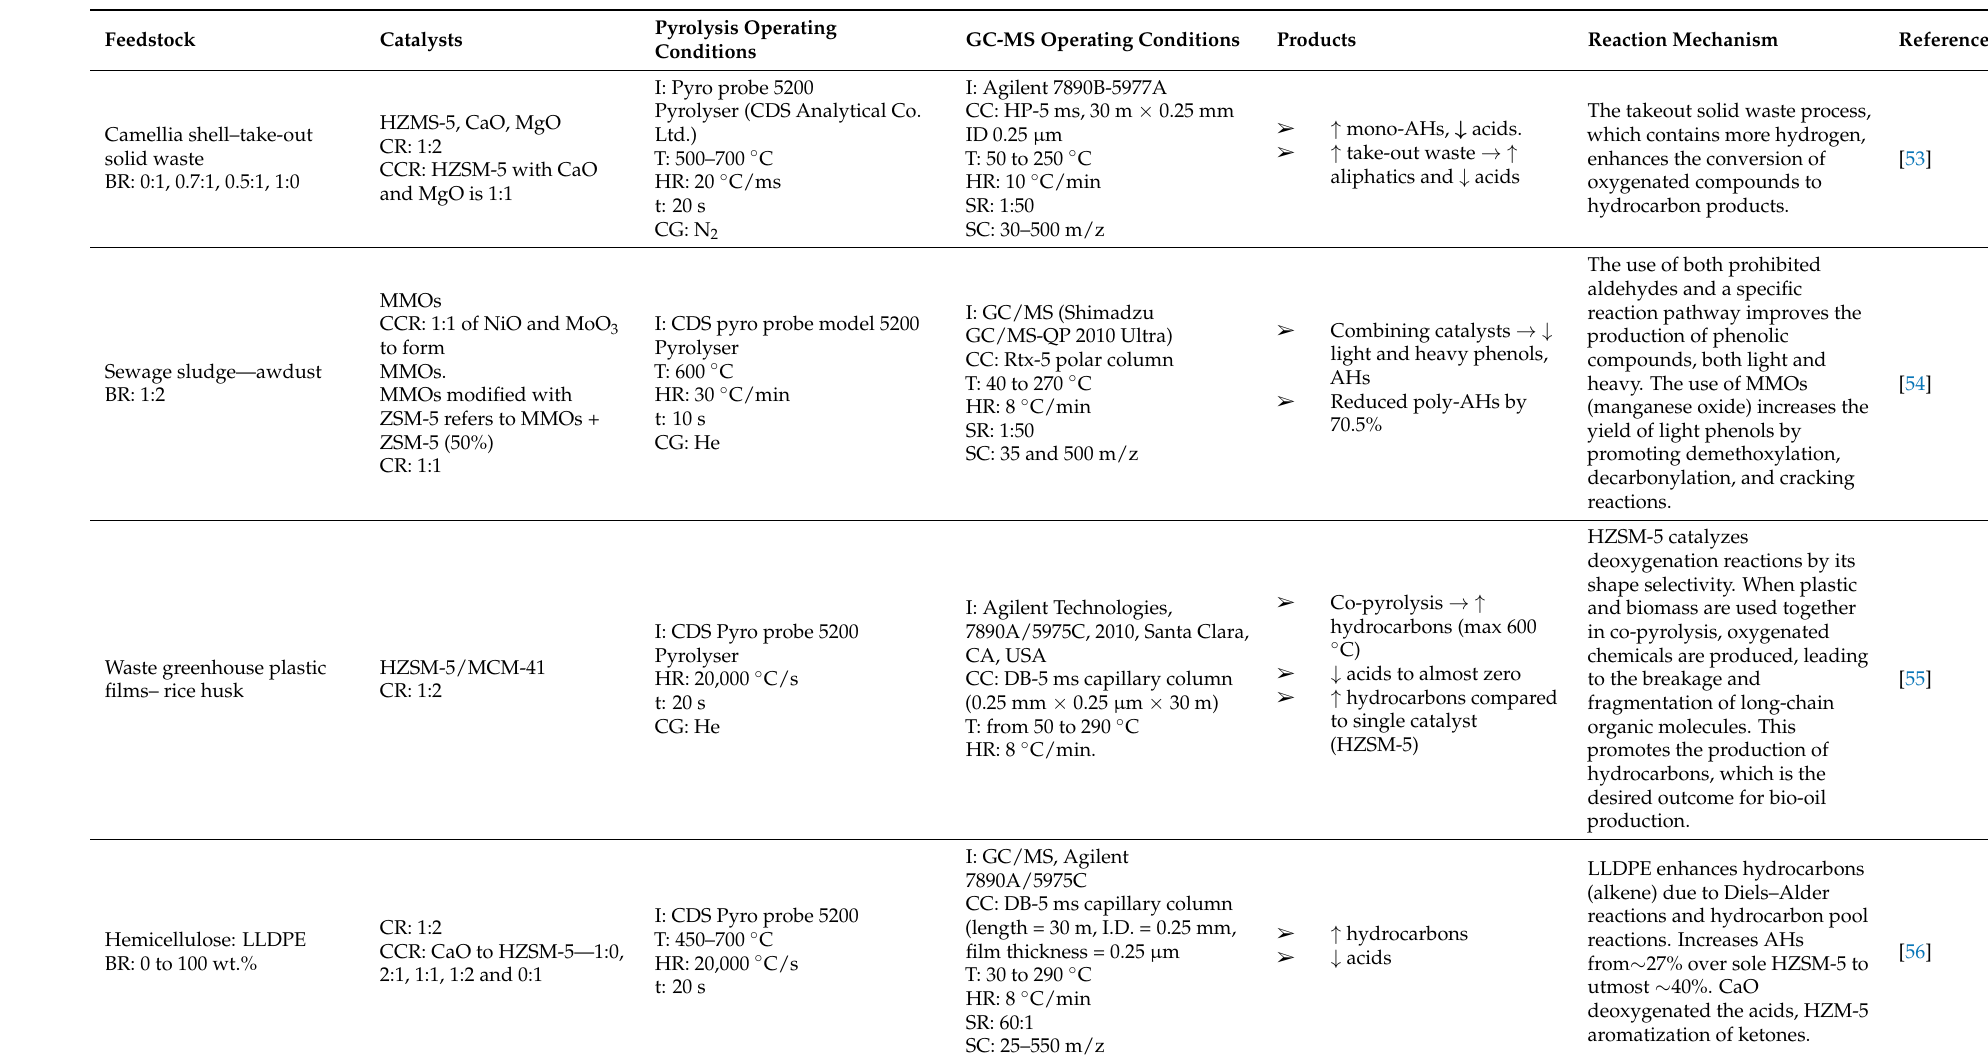
Table 2. Findings of zeolites in combination with other catalysts from selected articles reviewed in this